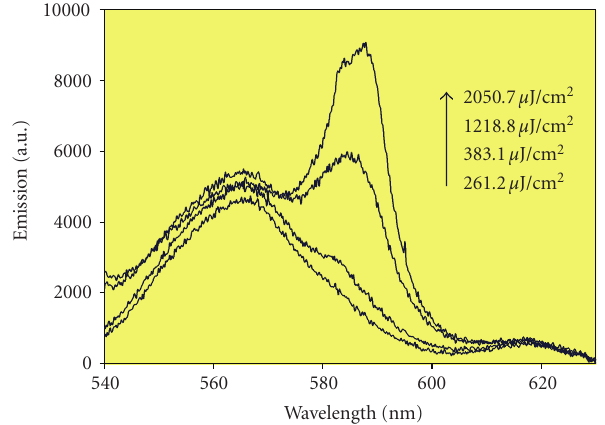
Figure 3: Photoluminescnce spectra of the surface emitting DFB laser made with the dye-doped 1D PC upon increasing the pump energy.